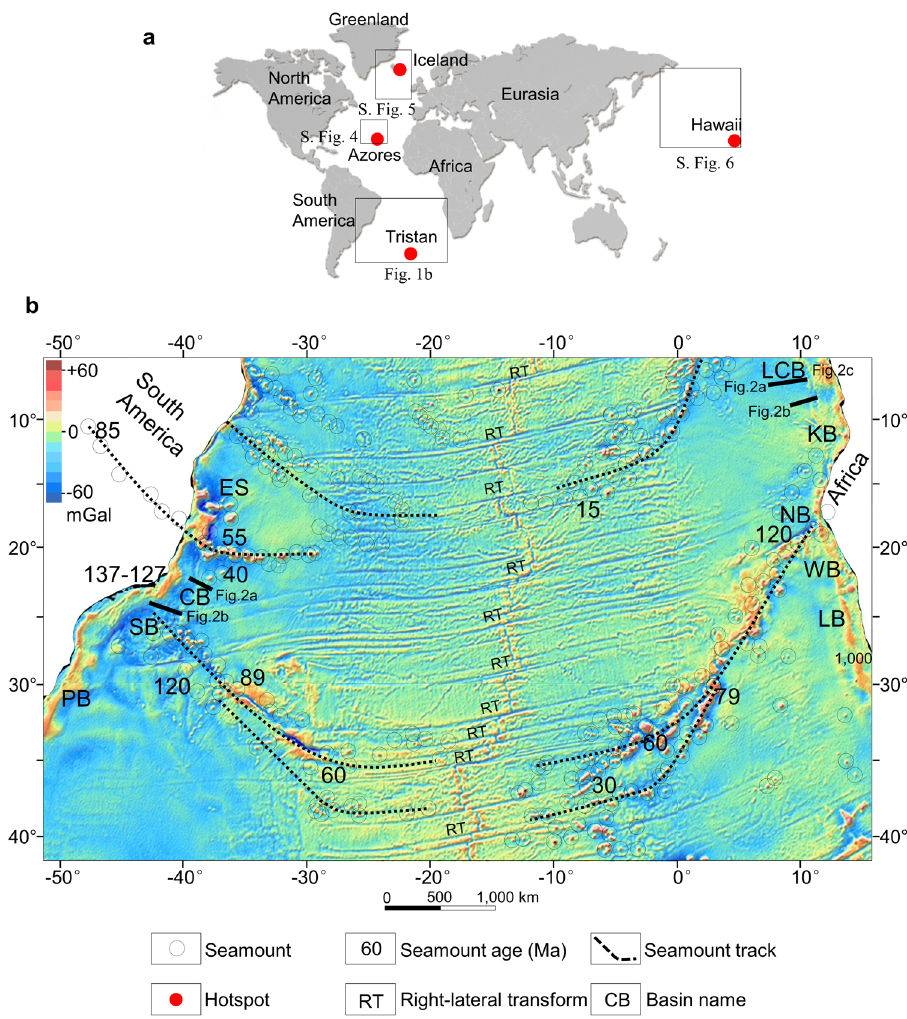
Fig. 1 An integrated data base of the South Atlantic Ocean. a Global location index map showing ocean basins and major hotspots discussed in this study. b South Atlantic Ocean base map. Color image shows satellite free-air gravity anomalies 25,26 . Along the South American margin, large-scale negative anomalies widen from north to south. Along the Mid-Atlantic Ridge, positive anomalies show increases in width and amplitude from north to south, and are systematically segmented by right-lateral transform faults (RT). Bull ’ s eye positive anomalies (circles) are seamounts 26 (Supplementary Fig. 1), and the numbers are seamount ages in m.y. 26,32 . The seamounts are distributed along non-linear chains. The trends and ages of seamount chains change from north, where they cross over fracture zones when they are older, to south, where they bend towards fracture zones when they are younger. Seismic data used in this study cover the following basins at the conjugate margins: Pelotas Basin (PB), Santos Basin (SB), Campos Basin (CB), Espirito Santo Basin (ES), Lower Congo Basin (LCB), Kwanza Basin (KB), Namib Basin (NB), Walvis Basin (WB), and Luderitz Basin